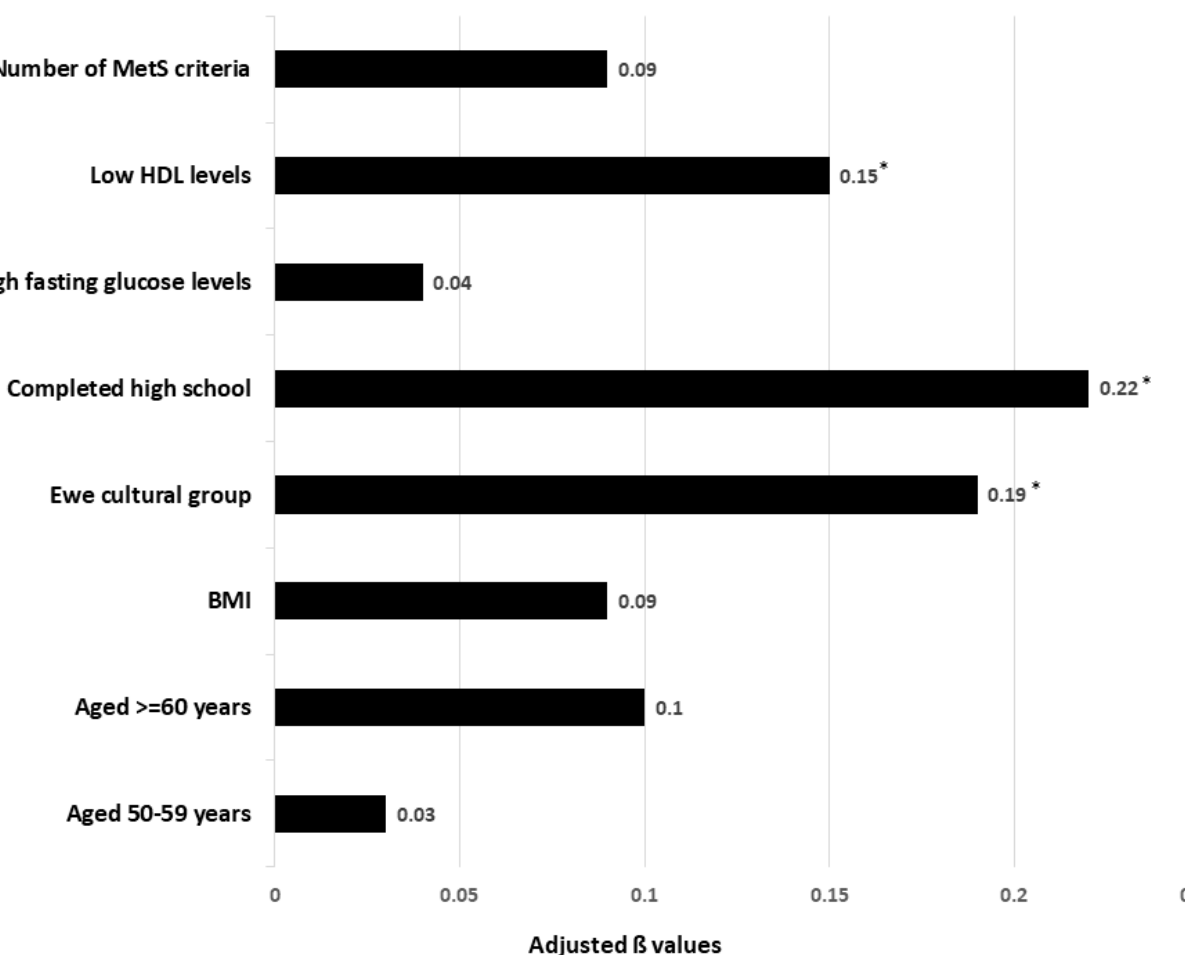
Figure 1. Factors associated with MetS knowledge (n = 338); F (8.329) = 6.3270, adjusted R 2 = 0.112 p < 0.0001. BMI = body mass index; HDL = high density lipoprotein cholesterol; * p < 0.05. The independent variables with p < 0.20 from univariate logistic regression were included in the multivariable logistic regression analysis for elevated blood pressure, elevate glucose levels, elevate triglyceride levels, low HDL levels as dependent variables, respectively (Figure 2). An age of 50+ is associated with an increased risk of low HDL levels, whilst having a better knowledge of MetS protects against low HDL levels. Waist is associated with higher risk of high fasting glucose levels and high triglyceride levels, whilst an age of 50+ protects against elevated blood